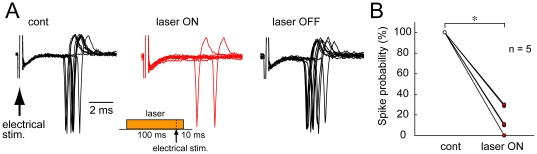
Photo-activation of axonal eNpHR inhibits spike activity in sSC neurons in vitro.
A, Left, In control condition, every optic nerve stimulation reliably evoked spikes recoded by cell-attached configuration in slice preparation. Middle, Laser illumination applied from 100 ms before to 10 ms after electrical stimulation (inset) suppressed the spike activity. Right, The reduced spike activity was recovered by turning off the laser. In each condition 10 traces were superimposed. B, Summary plot of spike probabilities following laser illumination for five cells. *P<0.001.